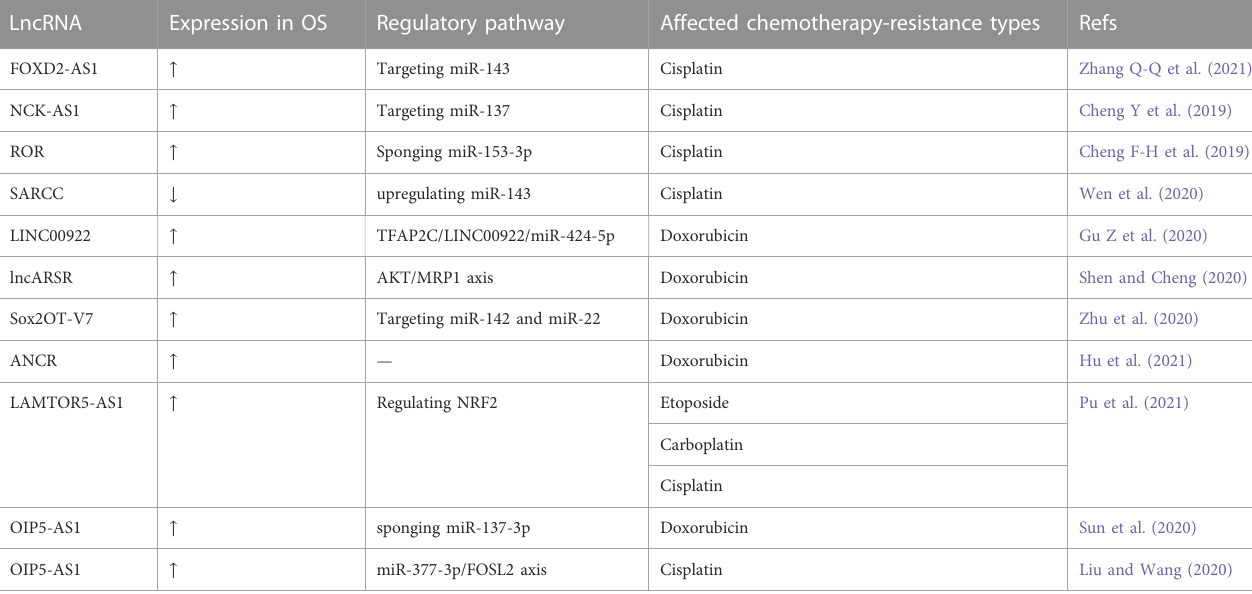
TABLE 9 LncRNAs associated with improved chemotherapy